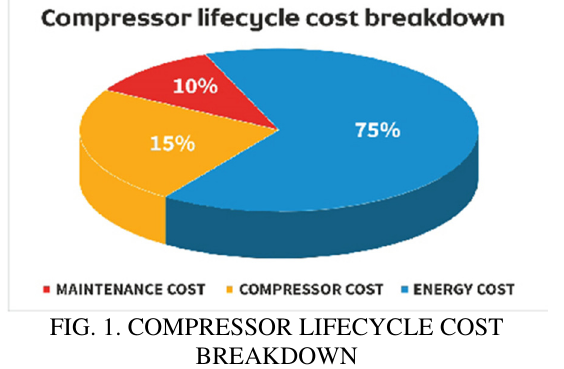
FIG. 1. COMPRESSOR LIFECYCLE COST BREAKDOWN